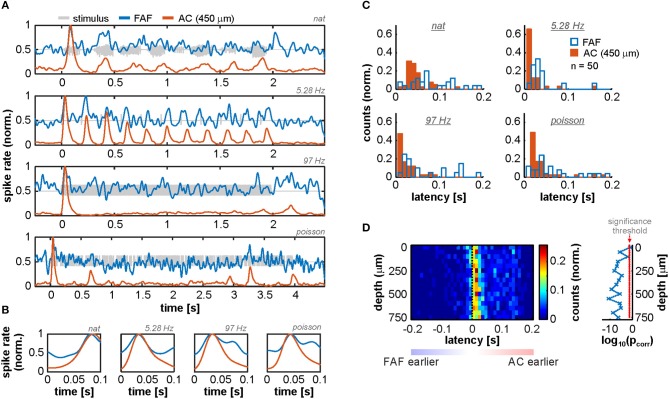
Spiking activity suggests the presence of fast inputs into the FAF. (A) Spiking responses from two simultaneously recorded units in the FAF (blue) and the AC (at 450 μm; orange), in response to all stimuli tested (top to bottom). (B) Zoom-in into the first 100 ms after stimulus onset of the examples shown in (A). Note that, for this pair, the peak response for the FAF unit was at least as fast as for the auditory cortical one. (C) Latency distribution of FAF units (blue) and AC units at 450 μm (orange), for all stimuli (n = 50 penetrations). The FAF was, overall, sluggish in comparison to the AC. (D) Response latency difference between simultaneously recorded spiking for FAF and AC at different depths (positive difference, FAF slower than AC; negative difference indicates the opposite). In some cases, FAF spiking responses occurred earlier than AC responses, although the AC was in general significantly faster than the FAF across channels, except in the case of the most superficial contact (FDR-corrected Wilcoxon signed rank tests, significance when pcorr < 0.05). Log-converted p-values and significance threshold are shown to the right of the latency distributions. The threshold is indicated as a red dashed line.